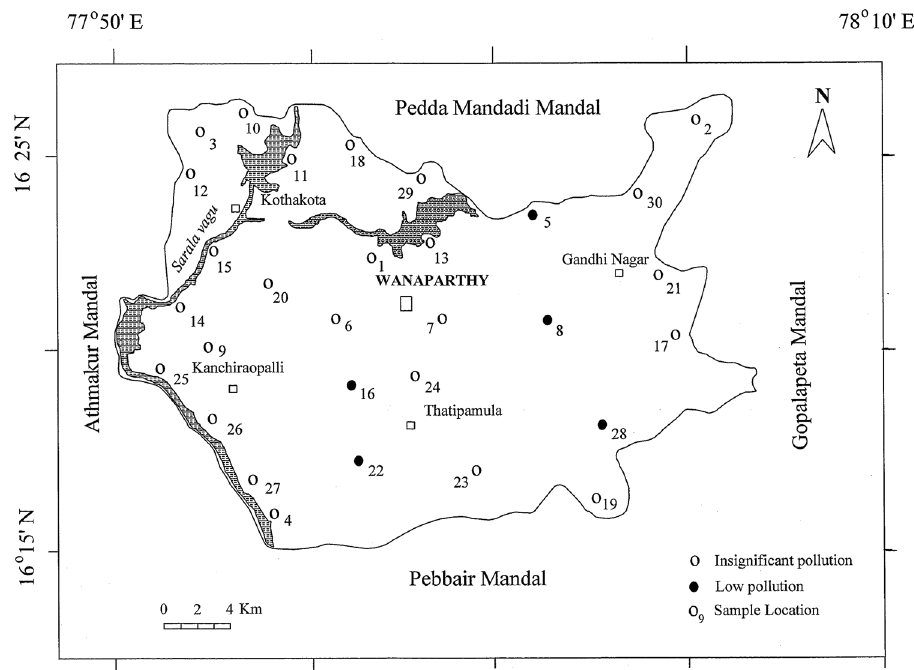
Fig. 4 Spatial distribution map of insignificant pollution and low pollution